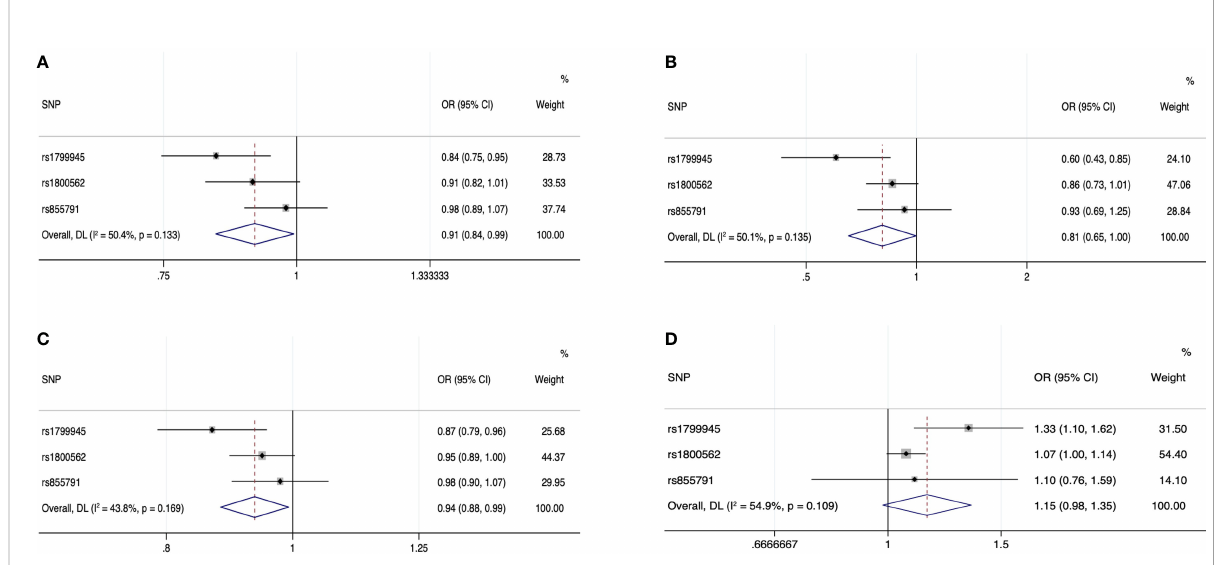
FIGURE 2 Forest plot of the MR estimates from the three instruments among European populations for serum iron (A) , log-transformed ferritin (B) , transferrin saturation (C) , and transferrin (D) on prostate cancer risk. The size of the squares is proportional to the precision of the MR estimates for each SNP, with the horizontal lines indicating their 95% CIs. The combined MR estimate is represented by the center of the diamond, with the lateral tips indicating its 95% CI. The solid vertical line is the line of no effect. Abbreviations: CI, con fi dence interval; MR, Mendelian randomization; SNP, single-nucleotide